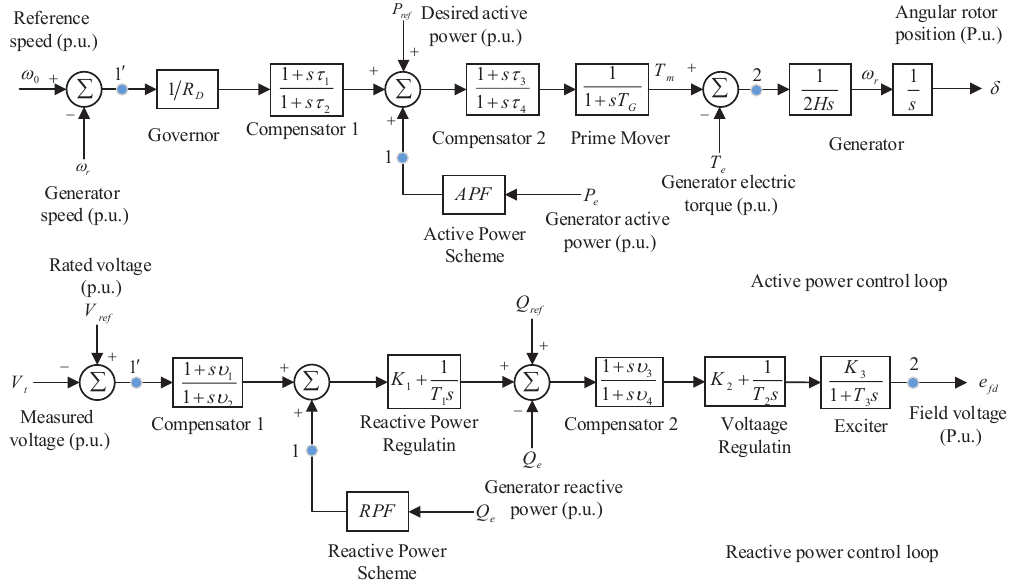
Figure 2. Proposed control loops for the synchronous